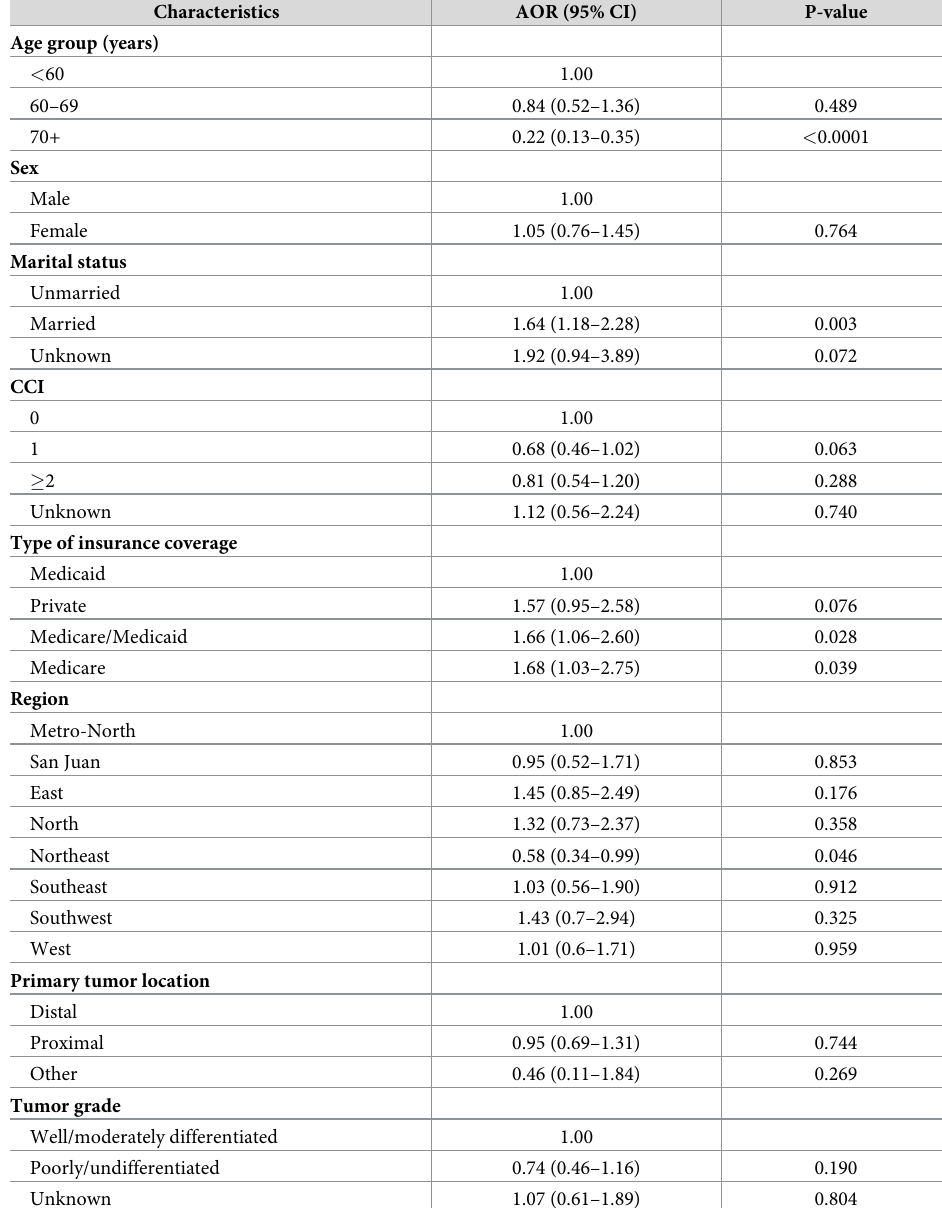
Table 4. Predictors of Receipt